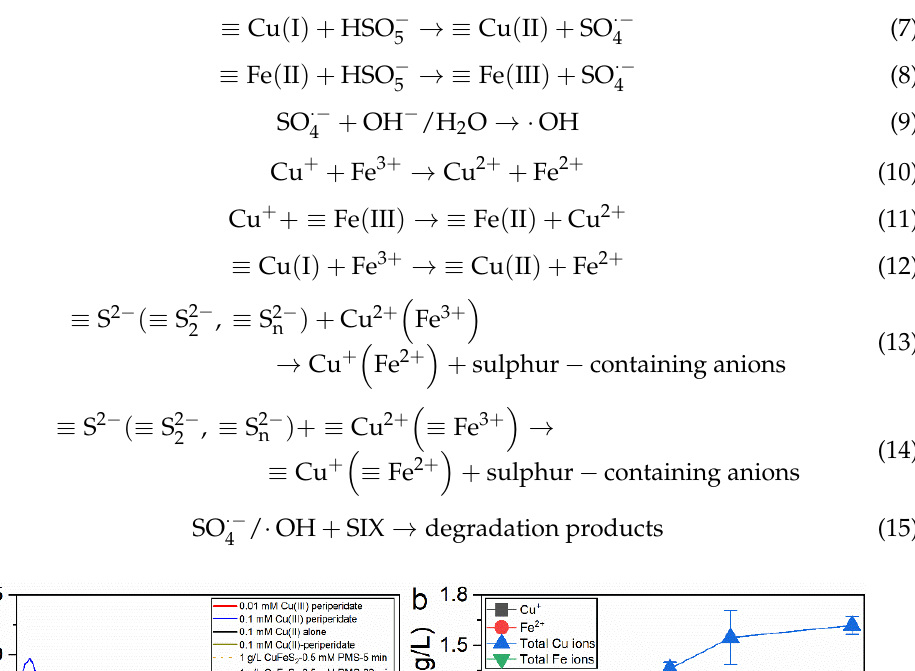
total dissolved copper (iron) ions and Cu + ions (Fe 2+ ) represents Cu 2+ (Fe 3+ ).